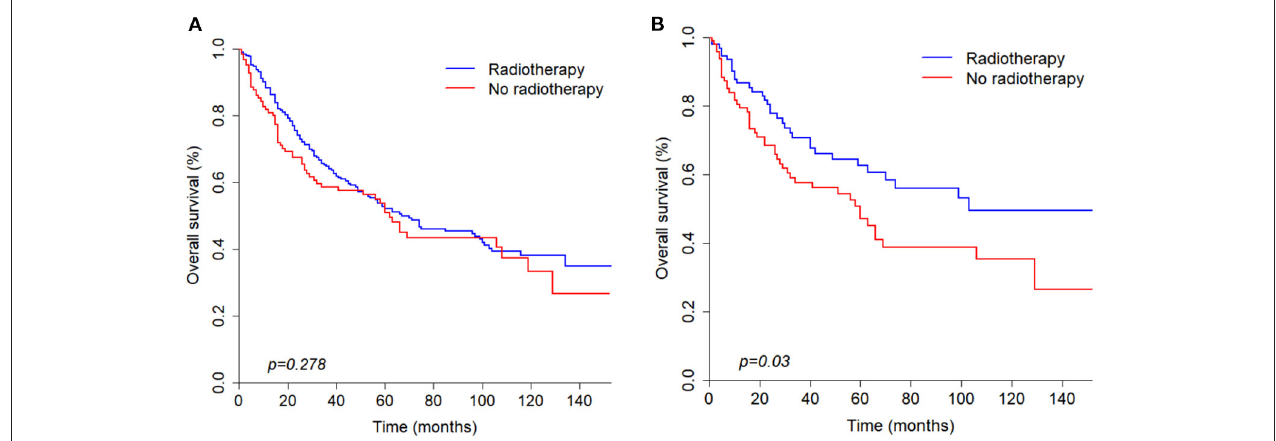
FIGURE 4 | Kaplan-Meier curves of overall survival before (A) and after (B) propensity score matching analysis based on